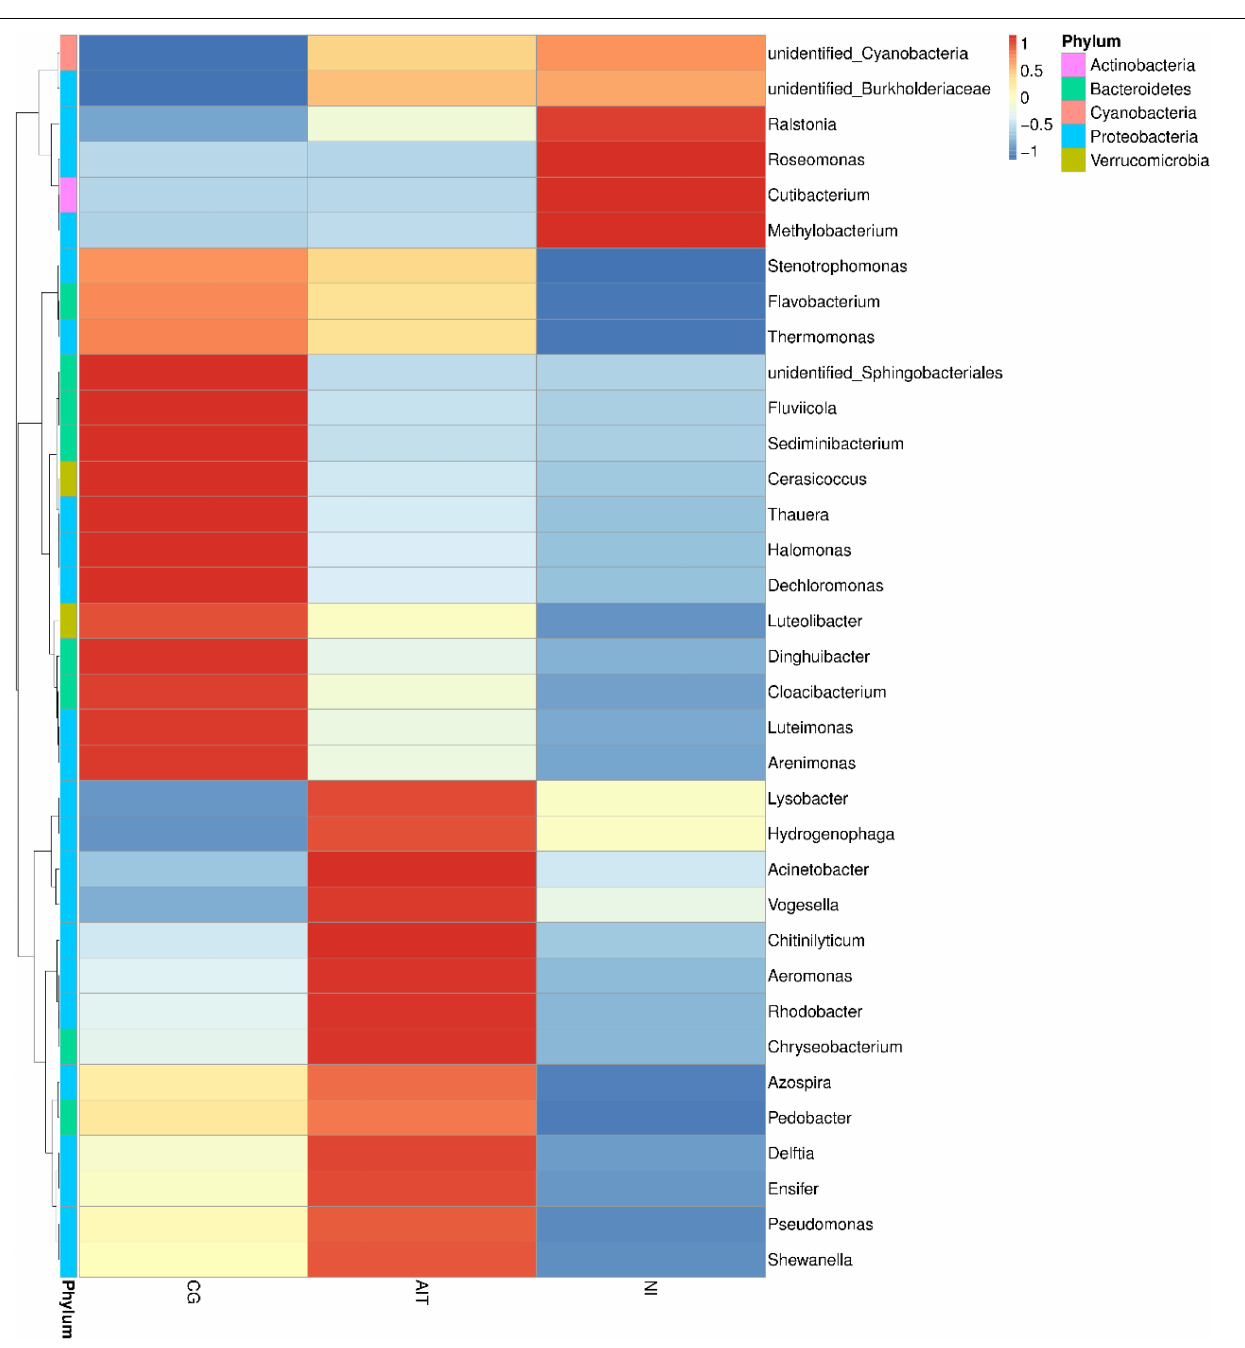
Frontiers in Microbiology |